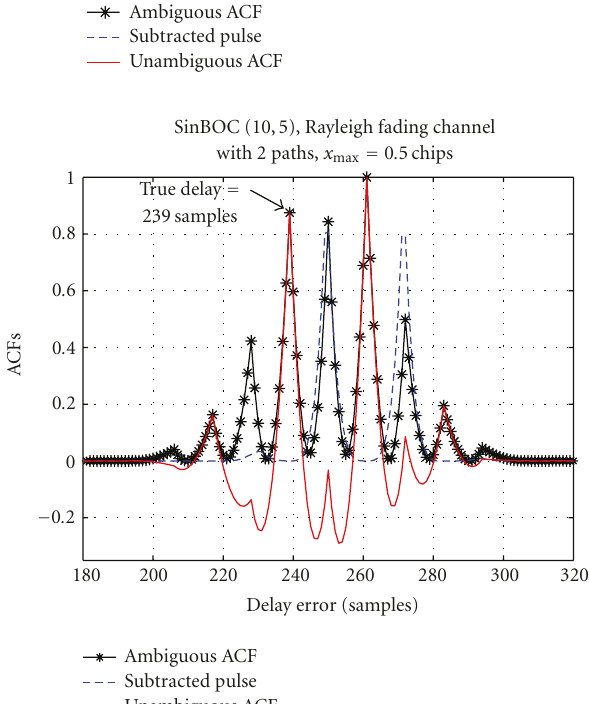
Figure 19: Comparison of feedback delays estimation algorithms employing the NEML discriminator and of the Julien&al. method, as a function of CNR; SinBOC(1,1) modulation, Rayleigh channel with an average pathspower delay profile of − 1, − 2, 0, and − 3dB, v = 75km/h, closely spaced paths with x max = 0 . 1